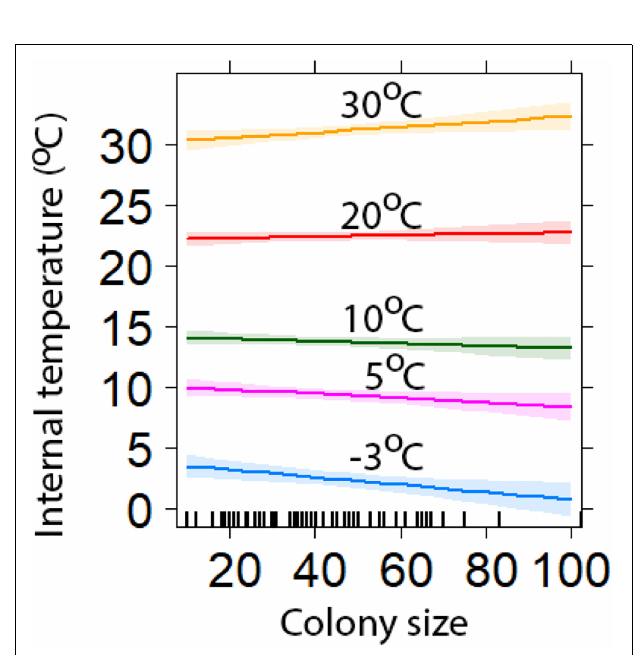
FIGURE 5 | Comparison of the insulation capabilities of different sized colonies compared with minimum temperatures ( ± 95% CI). Colony Size is determined by the number of chambers. The lines represent a range of external temperatures for a range of minimum values (model predicted values with 95% confidence